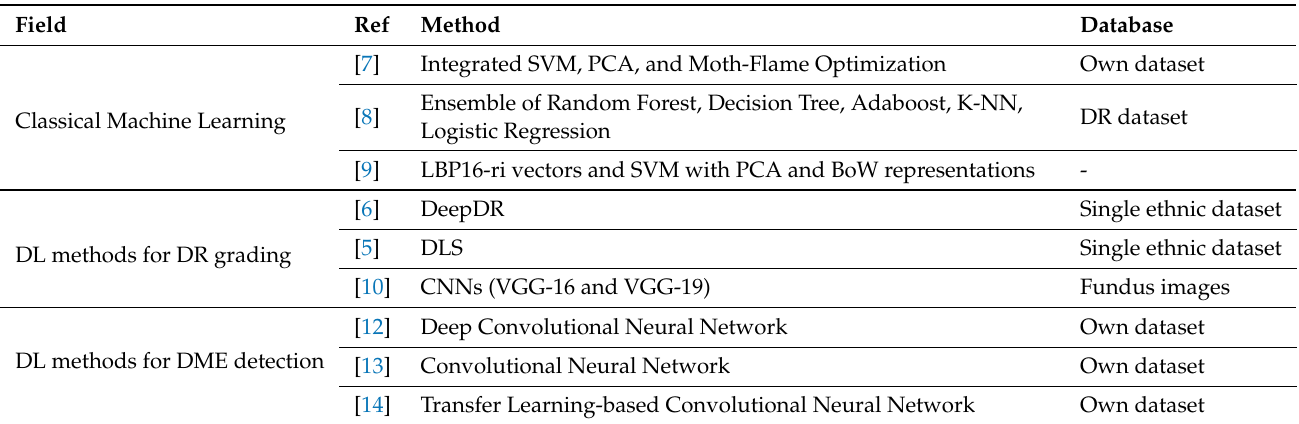
Table 1. Table summarizing classical machine learning and deep learning methods for diabetic retinopathy and diabetic macular edema detection and